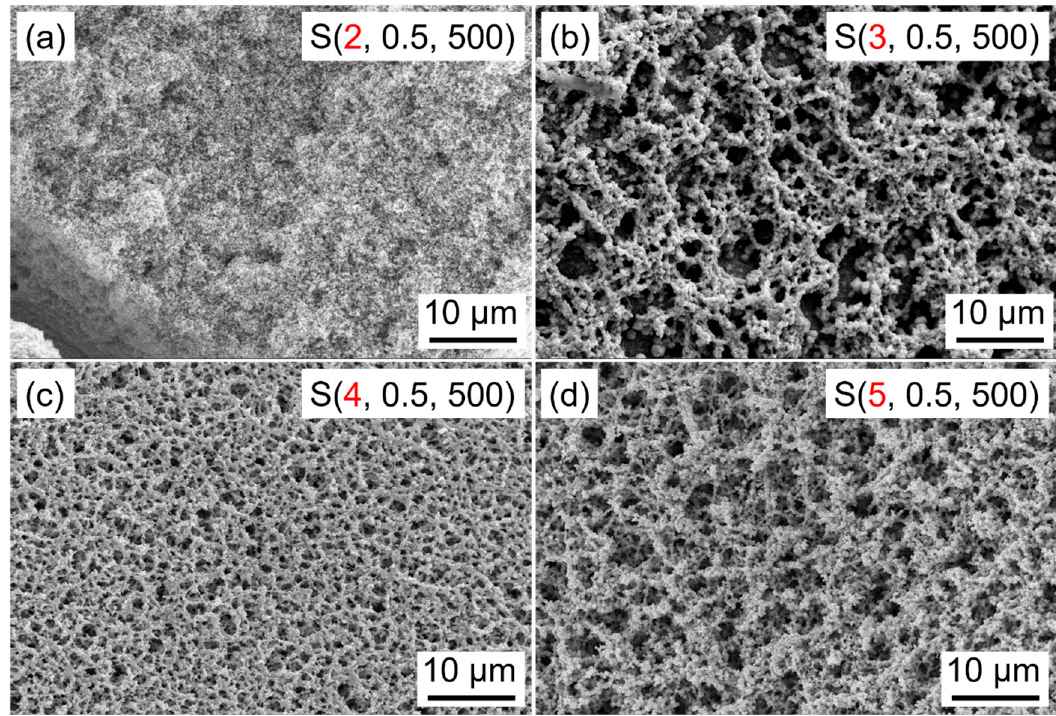
Figure 3. Scanning electron microscopy images of WO 3 films prepared at different aging times. ( a ) 2 h, ( b ) 3 h, ( c ) 4 h, ( d ) 5 h. Nanomaterials 2018 , 8 , x FOR PEER REVIEW